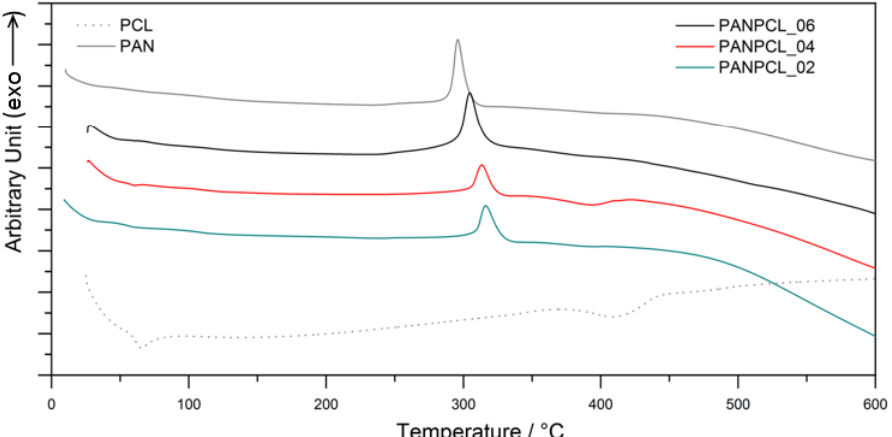
Figure 4. DTA of PAN/PCL samples of different composition performed under nitrogen atmosphere at the heating rate of 10 °C per min. at the heating rate of 10 ◦ C per